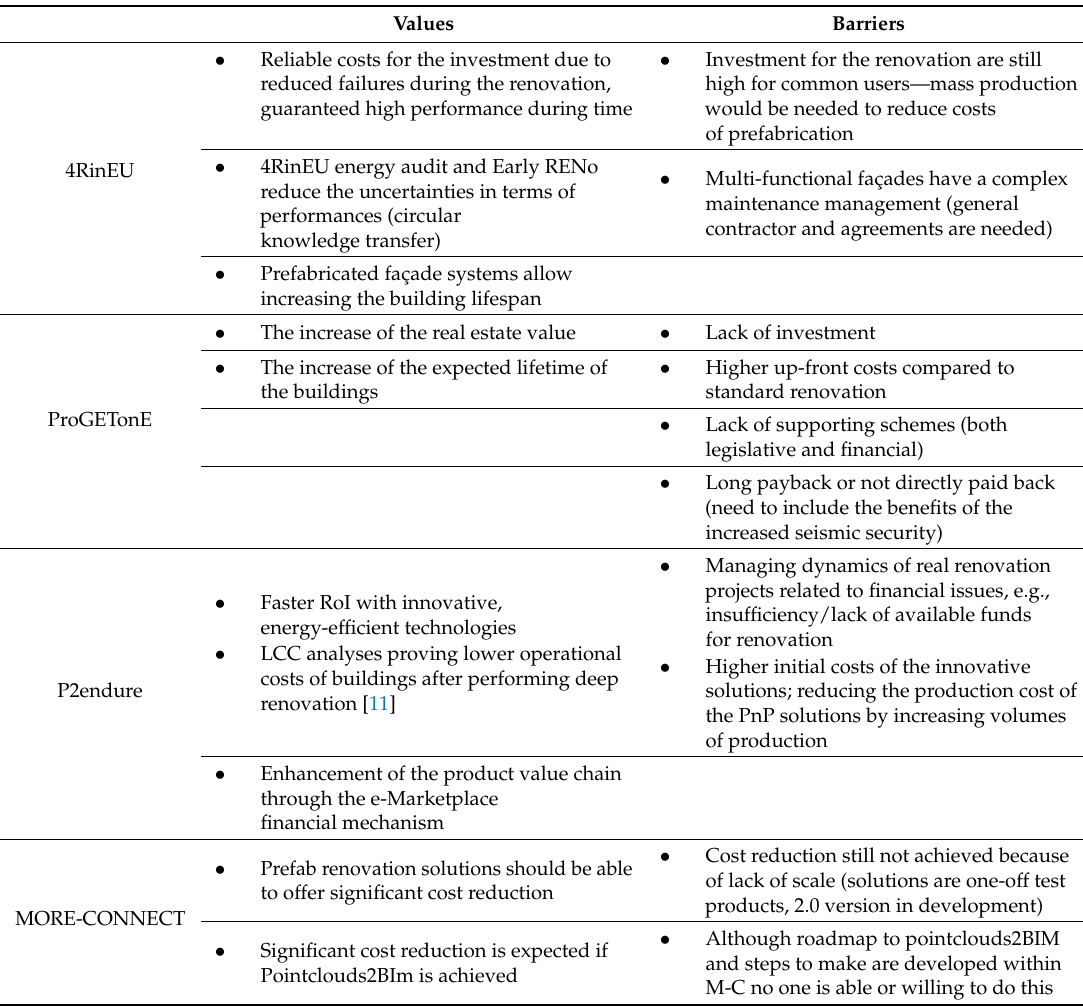
Table 5. Key financial added values and barriers emerged from the 4 Cluster